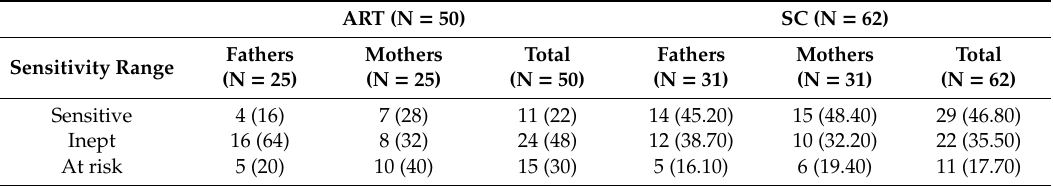
Table 4. Distribution of frequencies for sensitivity range between ART and SC parents.